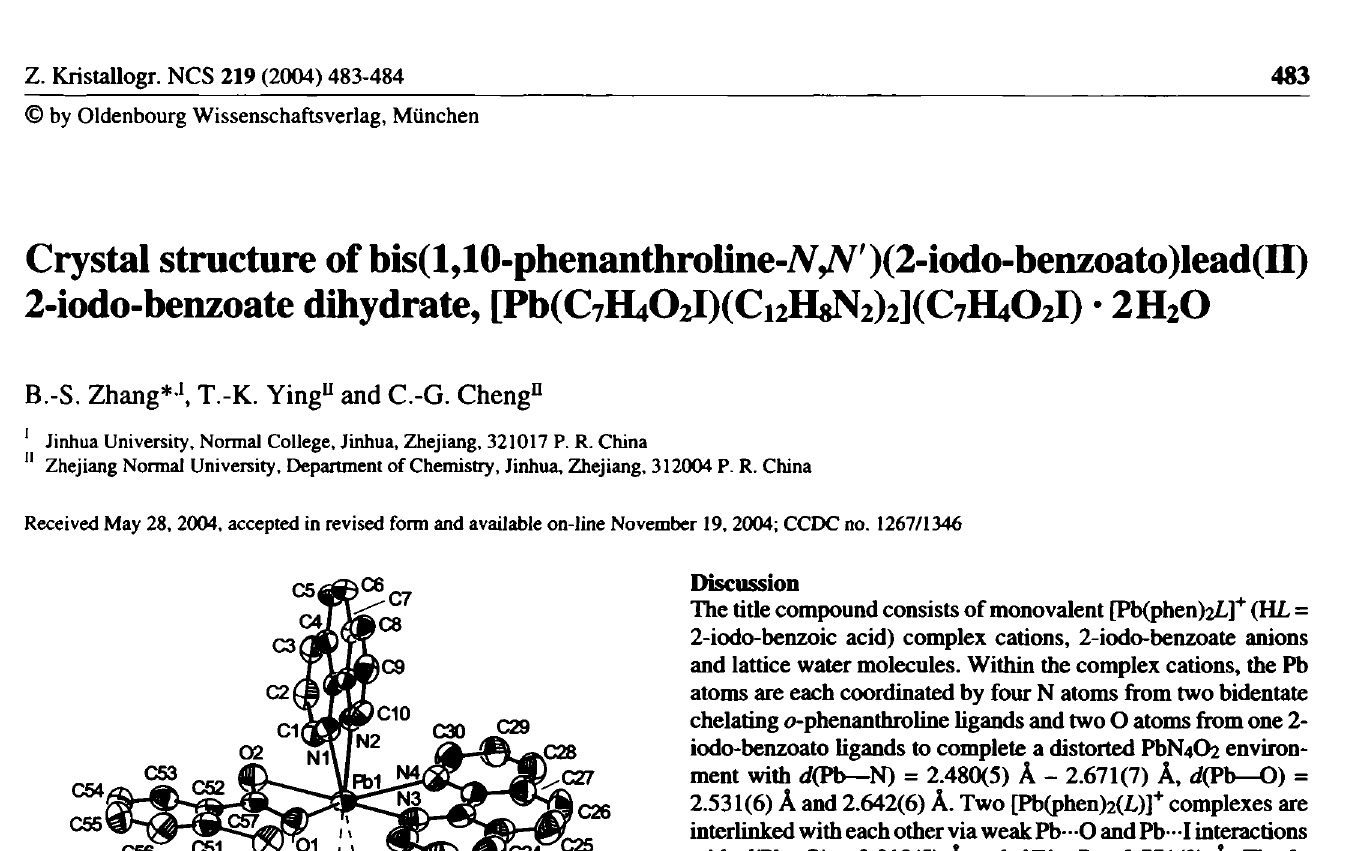
Table 1. Data collection and handling.